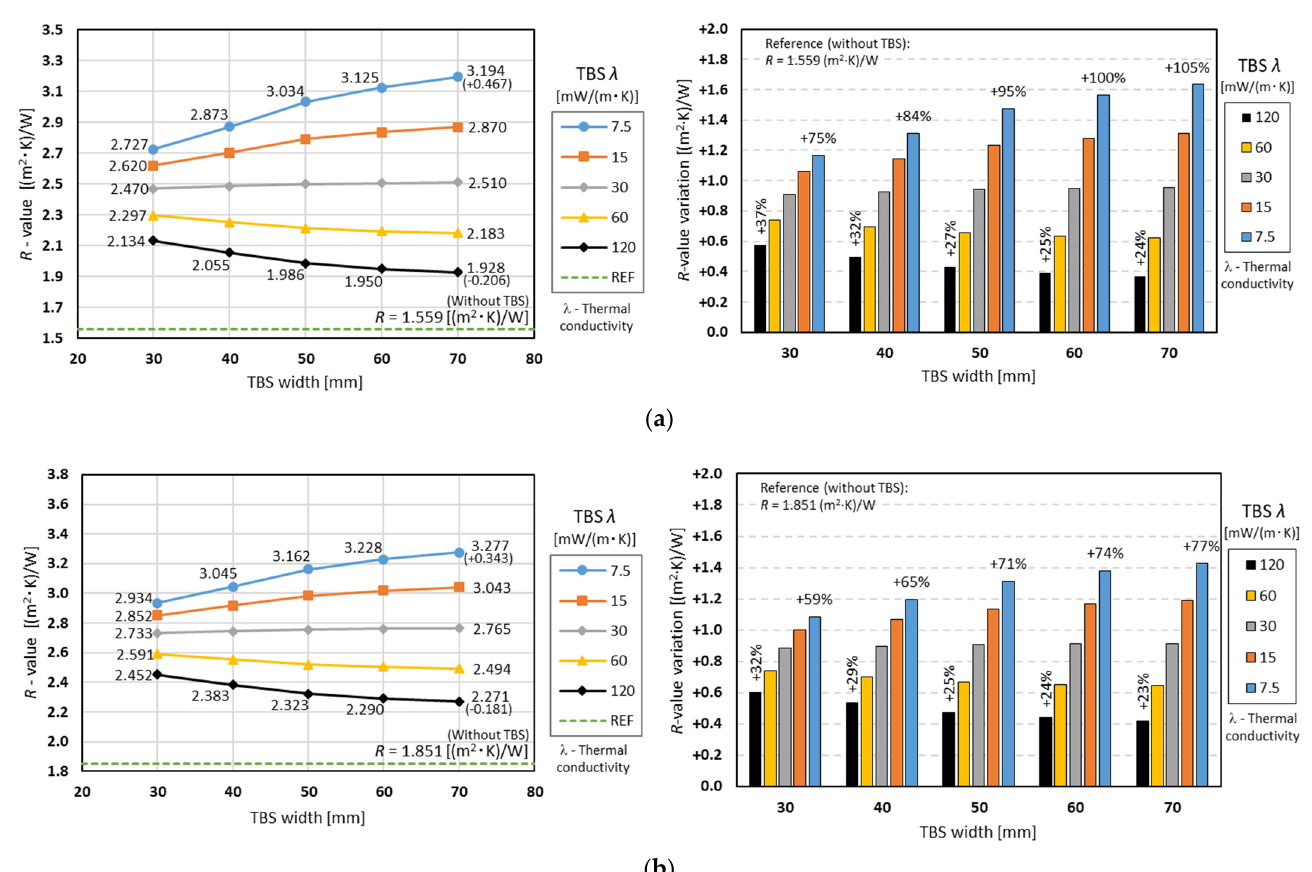
Figure 8. Surface-to-surface thermal resistances for LSF partitions, with two thermal break strips: 10 mm thick and variable width. ( a ) 400 mm stud spacing. ( b ) 600 mm stud spacing.